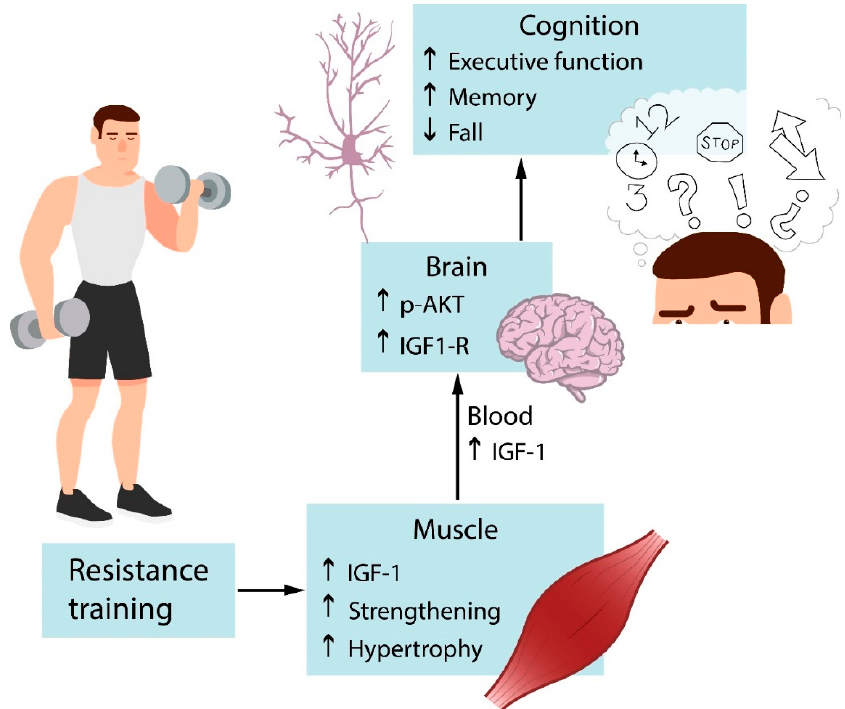
Figure 3. Effects of resistance exercise on cognition. Resistance training activates IGF-1 signaling in muscles, increasing muscle mass and strength. IGF-1 produced by muscles reaches the brain via circulation and binds to specific receptors that lead to the activation of signaling pathways. It acts on specific targets and results in improved cognition. IGF-1 = Insulin growth factor.